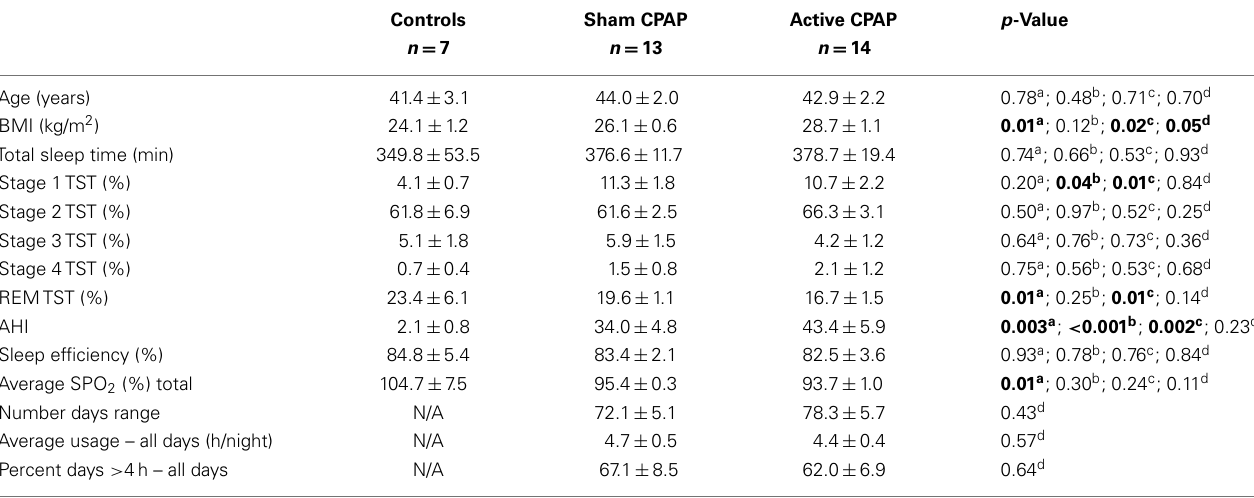
Table 1 | Baseline demographics, sleep, and treatment compliance variables for patients with obstructive sleep apnea syndrome (OSAS) treated with sham continuous positive airway pressure (CPAP) device or active CPAP device.